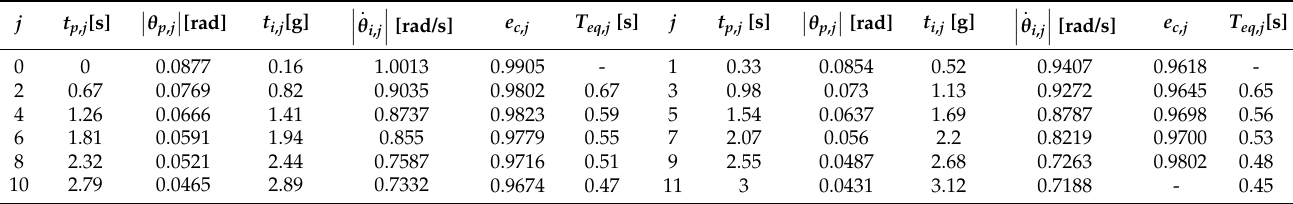
Table 4. Summary of the results of the free oscillation test block type A2.